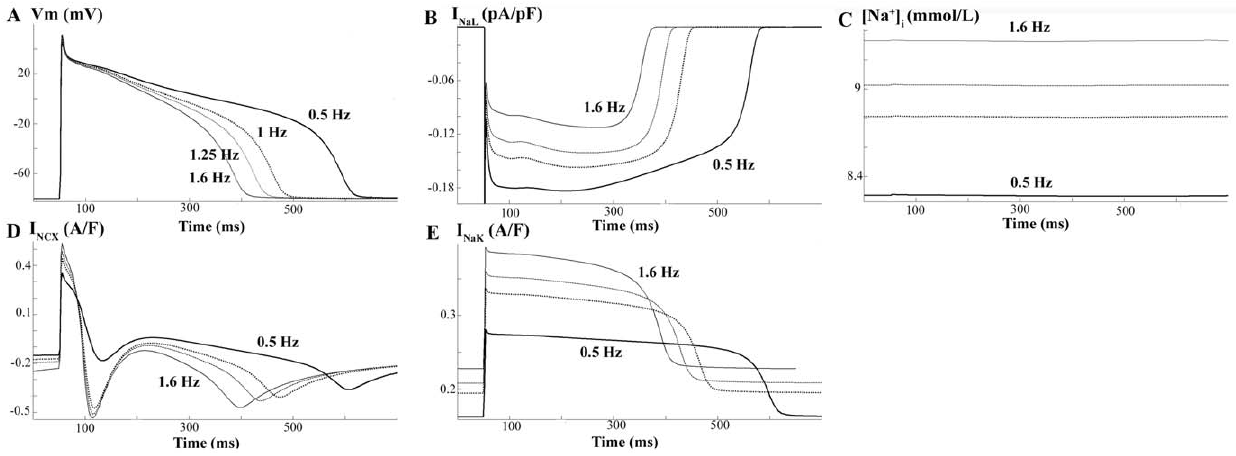
Figure 7. Mechanisms for APD rate-dependence in HF. Simulated APs and ionic currents at different stimulating frequencies (0.5, 1, 1.25 and 1.6 Hz) under HF conditions.